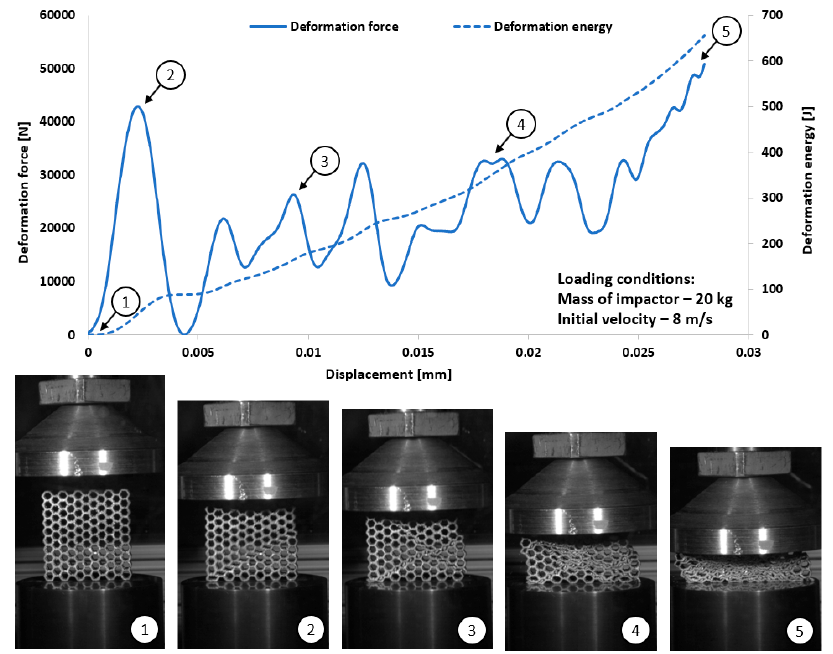
Figure 17. The results of dynamic tests obtained for honeycomb specimen No. 1 (1–5 stages of deformation during dynamic compression test).